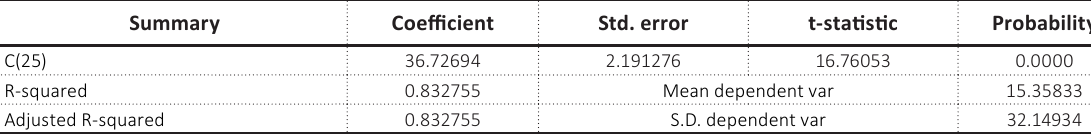
Table 8. Multivariate regression analysis